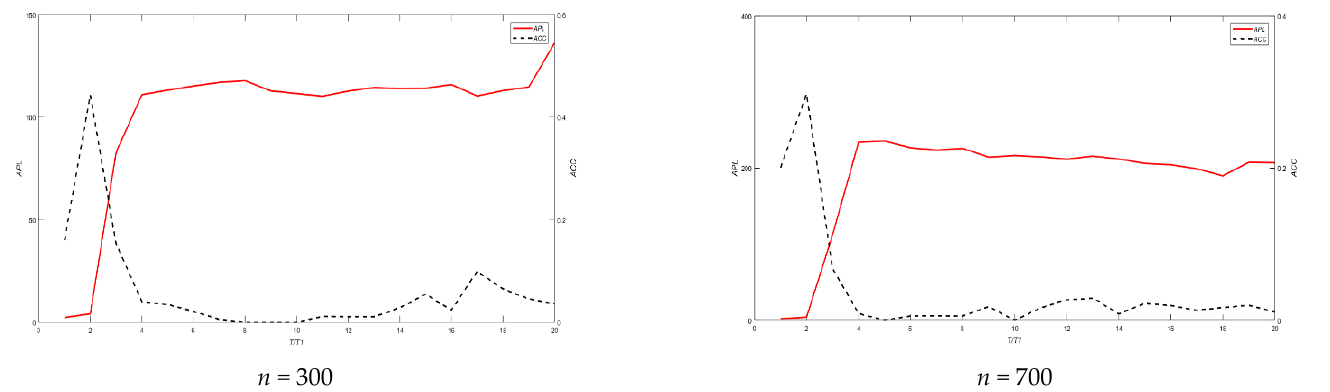
Figure 8. Effect of changes in population size n on APL and ACC.